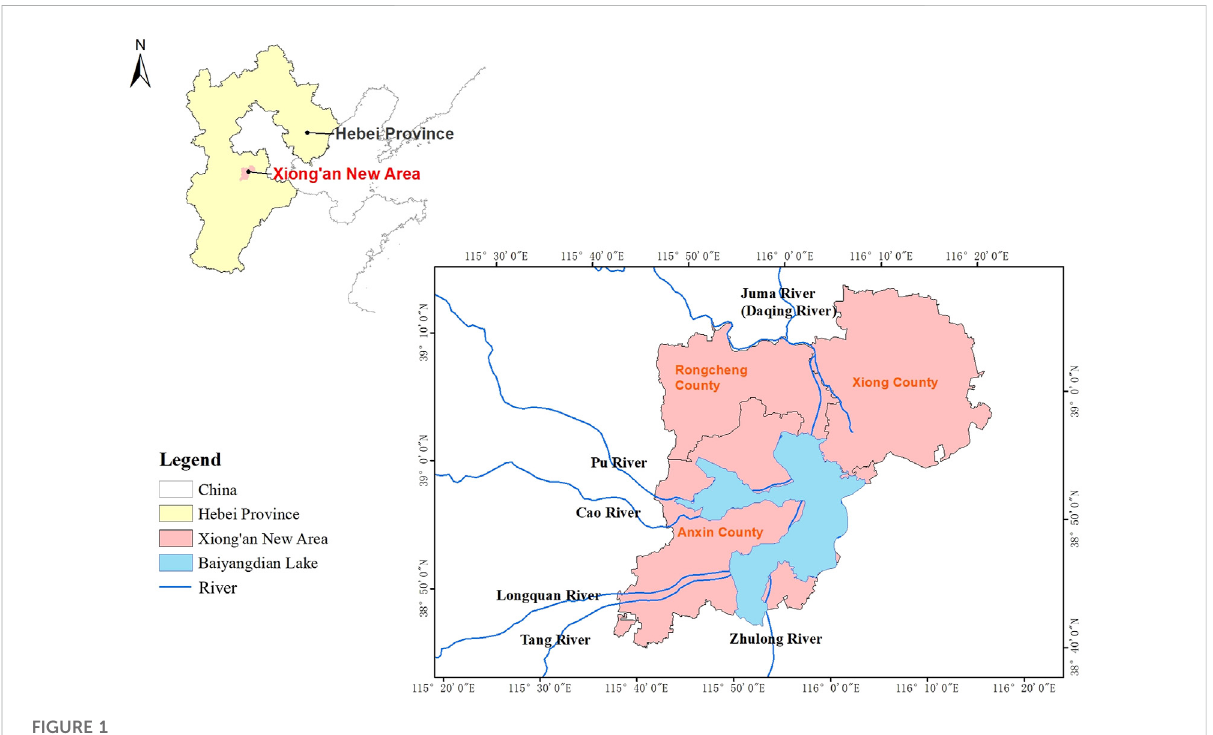
FIGURE 1 The location of the Xiong ’ an New Area, North